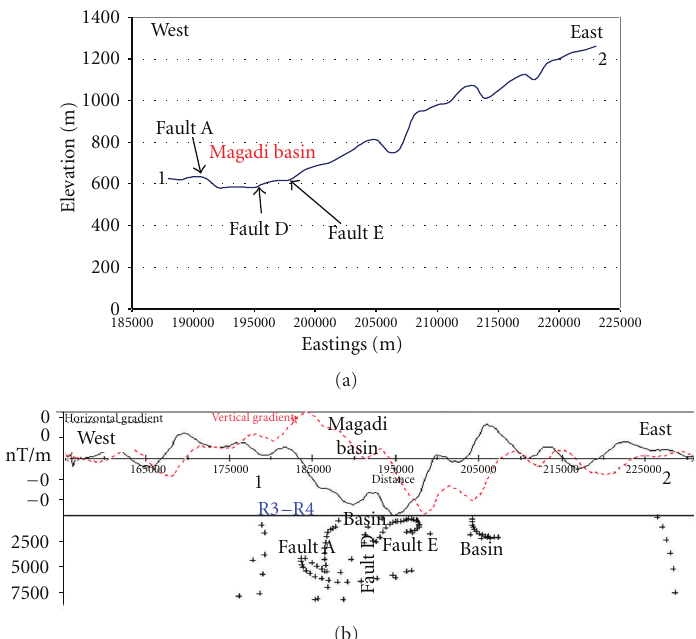
Figure 11: (a) Extracted topography elevations of Lake Magadi area from Aster DEM along flight line 330 showing surface faults and grabens. (b) 2D Euler deconvolution solutions from aeromagnetic data along flight line 320. The plus signs are structural index of